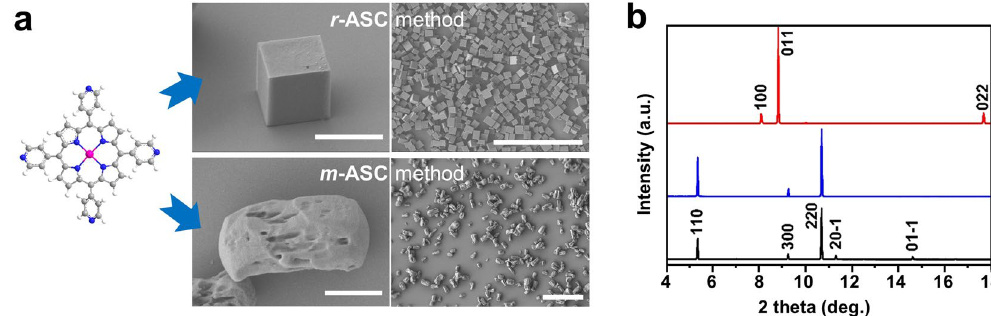
Figure 2. SEM images of the crystals synthesized by r -ASC and m -ASC method and their powder XRD patterns. (a ) High magnification (left column, scale bar = 5 μ m) and low magnification SEM images (right column, scale bar = 50 μ m) of ZnTPyP cubes and ZnTPyP precipitates grown by r -ASC and m -ASC method, respectively. ( b ) XRD patterns of commercial ZnTPyP powder (black), irregular precipitates obtained by the m -ASC method (blue), and cube-shaped crystals obtained by the r -ASC method (red). All of the spectra were converted to the wavelength of the Cu K α 1 line ( λ = 1.54057